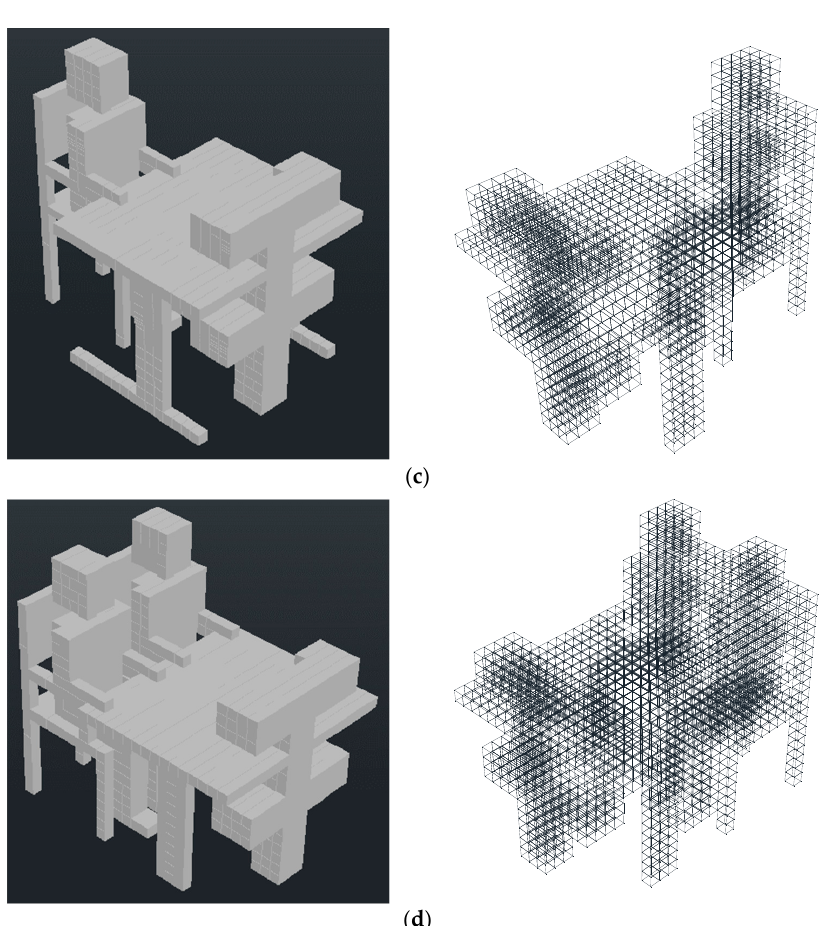
Figure 2. Scheme used in the integral computational fluid dynamics (CFD) virtual classroom model simulation for ( a ) 6 and ( b ) 12 occupants and grid generation in a desk, personalized ventilation system (PVS), occupant and desk details for ( c ) 6 and ( d ) 12 occupants.